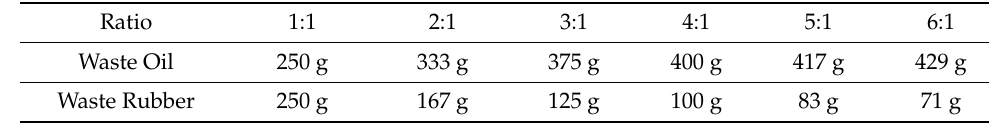
Table 1. Mixture ratio between waste oil and waste rubber.